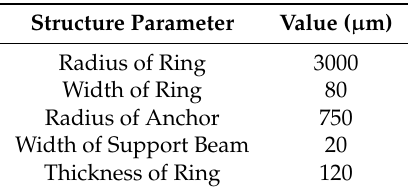
Table 2. Partial structure parameters of